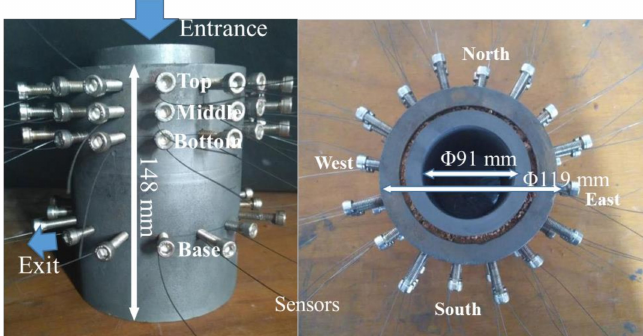
Figure 1. Schematic diagram of a laboratory vessel mimicking blast furnace hearth (left: front view, right: top view, and thin molybdenum alloy lines: electromotive force (EMF)